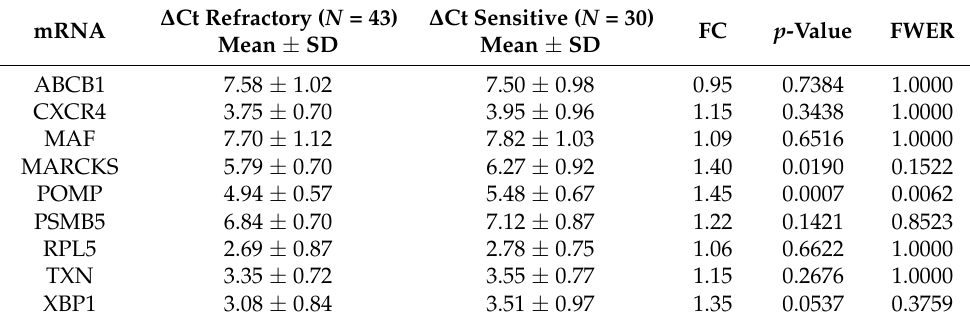
Figure 2. Dot plot representation of the ∆ Ct values of differentially expressed mRNA. The box plots depict the mean and SD. A higher ∆ Ct value represents the lower expression of the gene at the mRNA level: ( A ) ∆ Ct of RPL5 in multiple myeloma patients healthy donors ( p = 0.0033) and ( B ) ∆ Ct of POMP in sensitive and refractory to bortezomib MM patients (0.0062). Table 3. mRNA expression in MM patients sensitive and refractory to bortezomib-based chemotherapy. The higher ∆ Ct value represents the lower expression of gene at mRNA level.